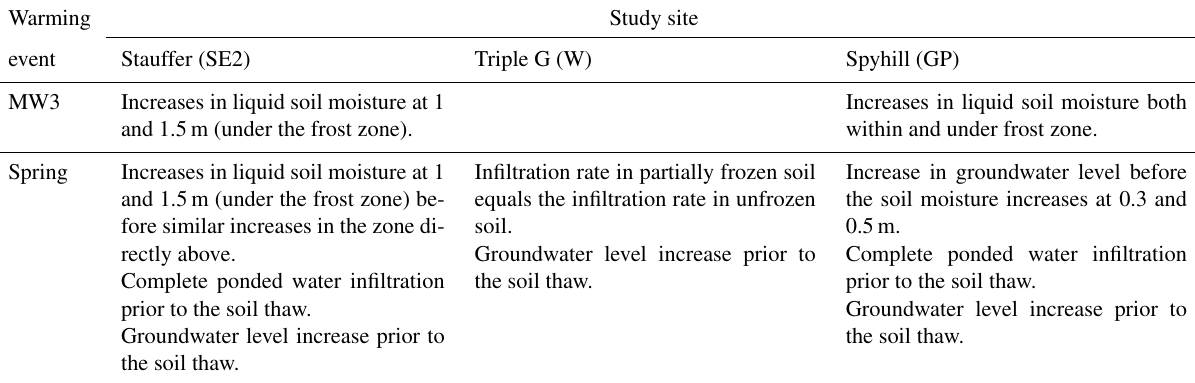
Table 4. Observations of the preferential flow in frozen soil under depressions at the study sites. Warming Study